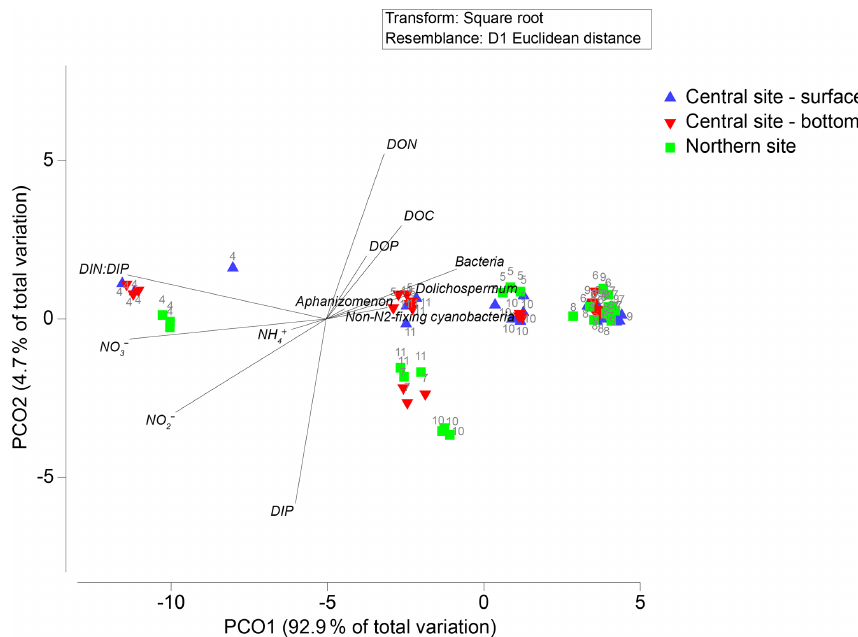
Figure 3. Principal coordinate biplots generated on Euclidean distances of normalized and fourth-root-transformed nutrient concentrations (DOC, NH + , NO − , NO − , DON, DIP, DOP, and DIN : DIP). Overlaid vectors show individual chemical variables (those significantly corre- 4 2 3 lating with either of the two primary axes, with Pearson correlations > 0 . 5) and plankton community biomass of Aphanizomenon, Dolichos- permum , non-N 2 -fixing cyanobacteria, and heterotrophic